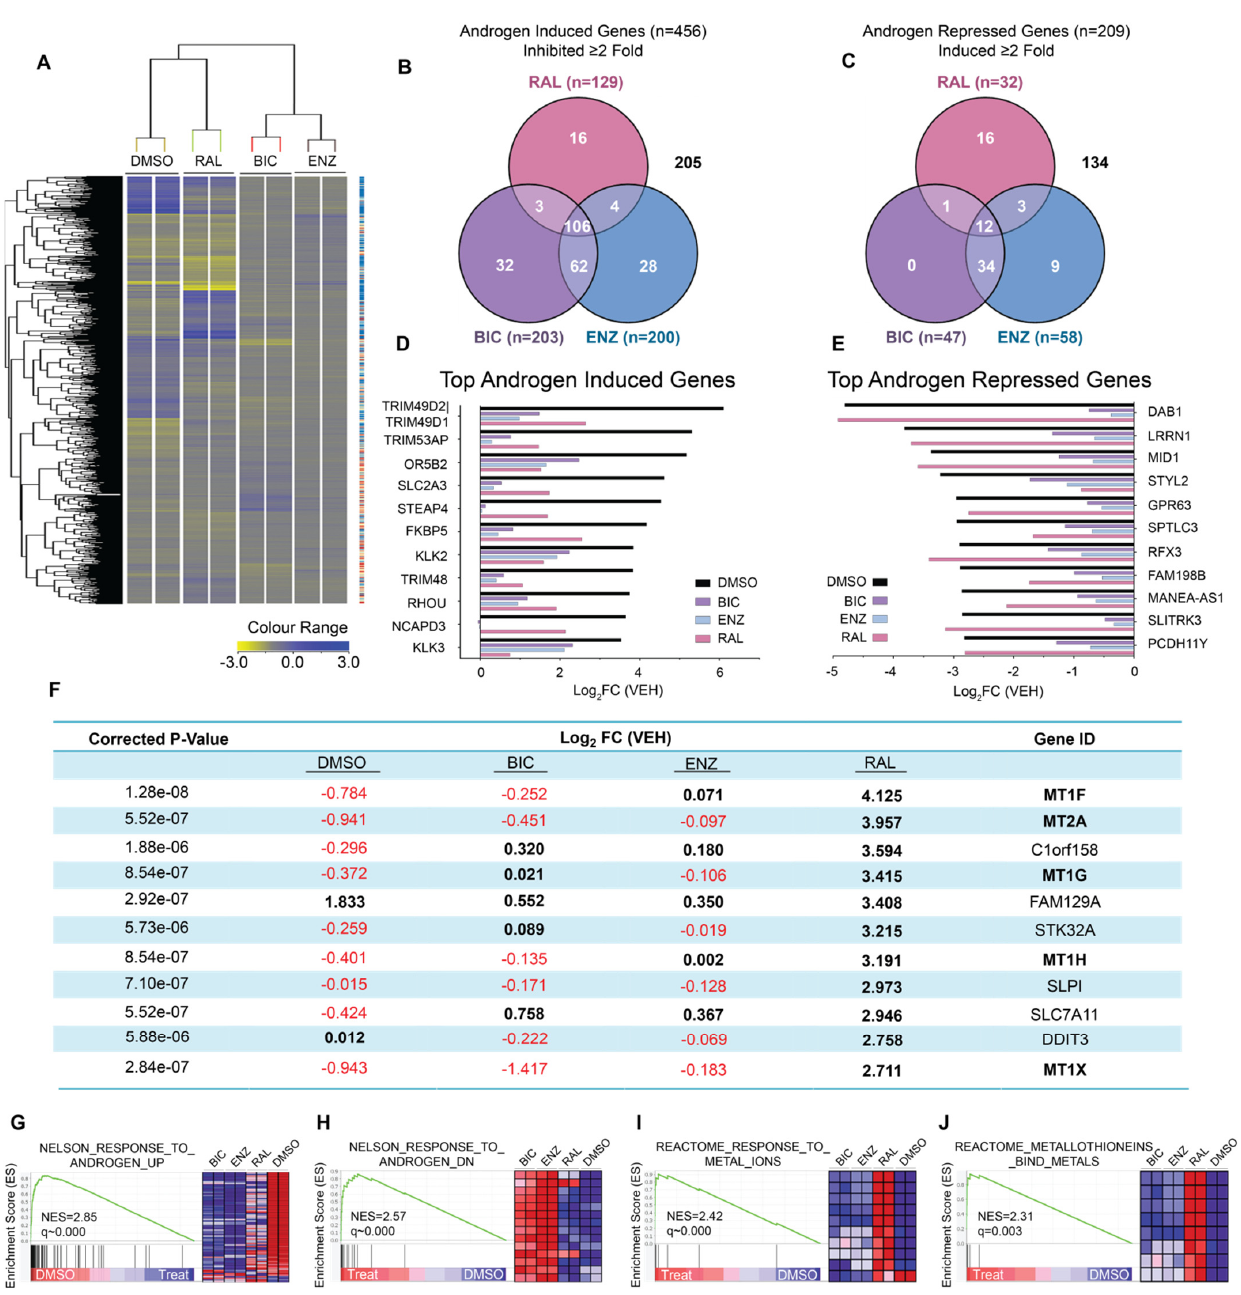
Figure 1. Differential gene expression profiles between AR-LBD inhibitors and an AR-NTD inhibitor. ( A ) Heatmap showing differentially regulated genes following treatment with bicalutamide (10 µ M), enzalutamide (5 µ M) , ralaniten (35 µ M), or DMSO vehicle (R1881 only), and all stimulated with 1 nM R1881 for 24 h. Data were normalized to vehicle treated with EtOH (no R1881). Analysis of global gene expression identified androgen-regulated genes that were specifically induced ( n = 456) ( B ) or repressed ( n = 209) ( C ). The Venn diagrams show the numbers of androgen-regulated genes in these subsets whose expression decreased/increased by ≥ 2-fold in the presence of bicalutamide, enzalutamide, or ralaniten. Numbers outside Venn diagrams indicate genes that were not affected by any drug treatment. Top androgen-induced ( D ) and -repressed ( E ) genes ranked by fold-change normalized to DMSO/EtOH (no R1881). LNCaP cells were incubated with enzalutamide (ENZ, 5 µ M), bicalutamide (BIC, 10 µ M), ralaniten (Ral, 35 µ M), or DMSO vehicle (with and without 1 nM R1881). All drug treatments were stimulated with 1 nM R1881 for 24 h before harvesting and